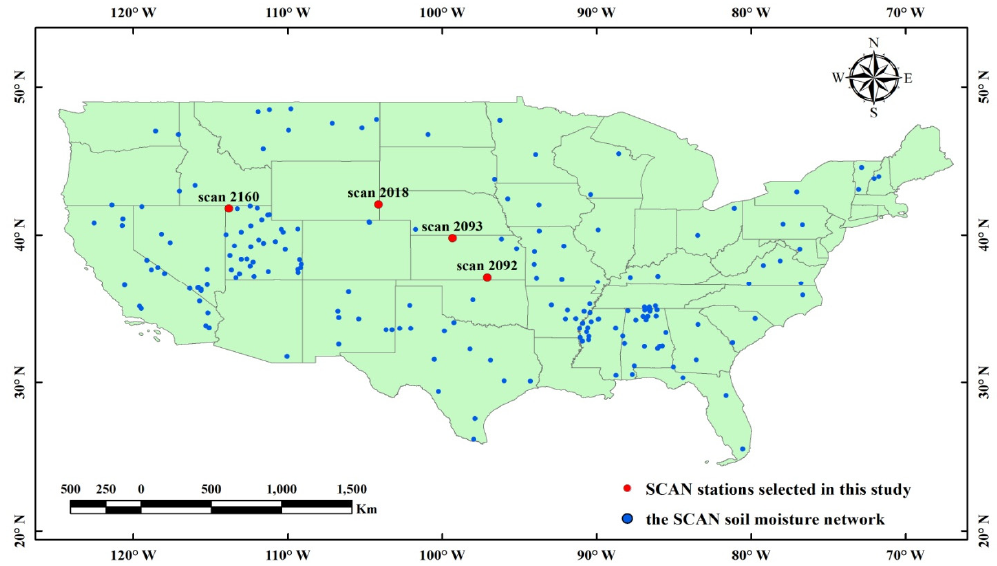
Figure 1. General map of the SCAN Soil Moisture network (blue labels) and the four SCAN stations selected in this study (red labels).